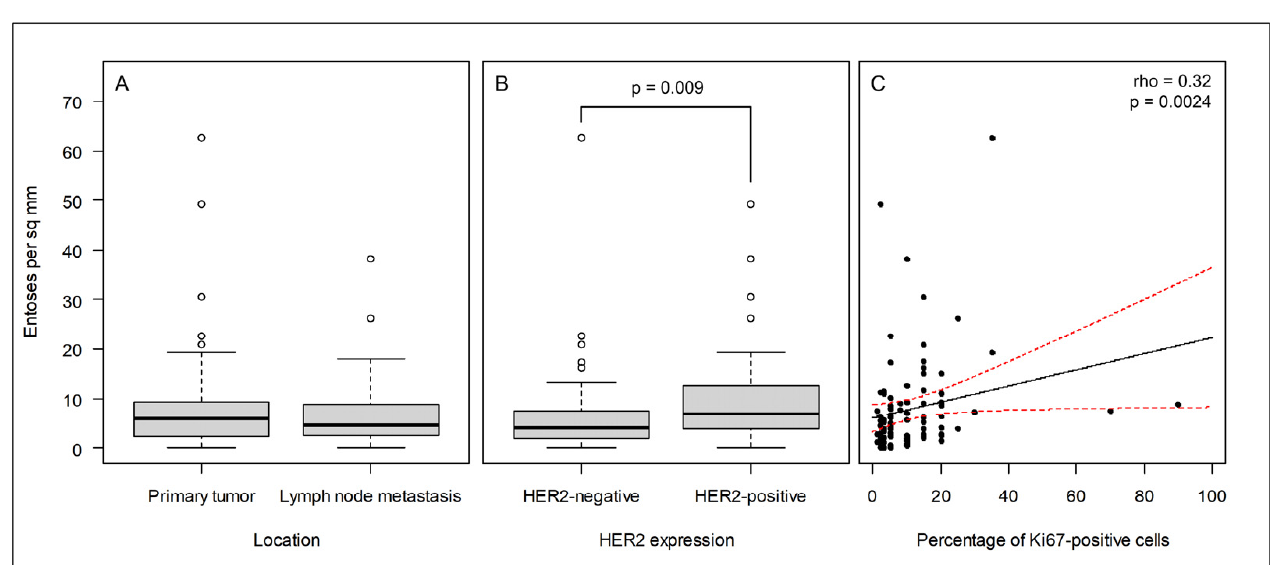
Figure 2. In the cohort of breast cancer patients, entosis correlates with the HER2 and Ki67 cancer markers. ( A ) The frequency of entoses does not differ between primary tumors and lymph node metastases; ( B ) the frequency of entoses is significantly higher in HER2-positive cancers than in HER2-negative cancers; ( C ) the frequency of entoses correlates with Ki67 expression. The black and red lines indicate the best linear fit and its 95% confidence interval, respectively.